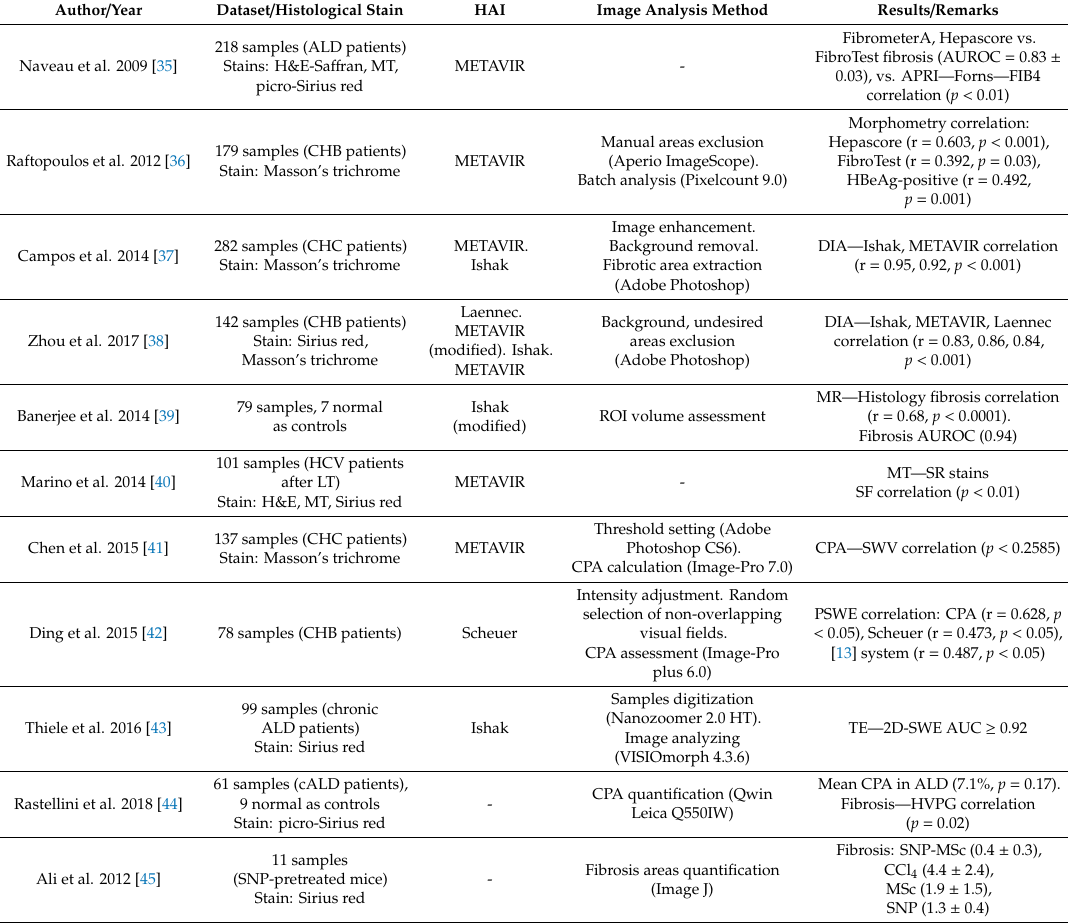
Table 3. Studies comparing histopathological imaging with non-invasive imaging